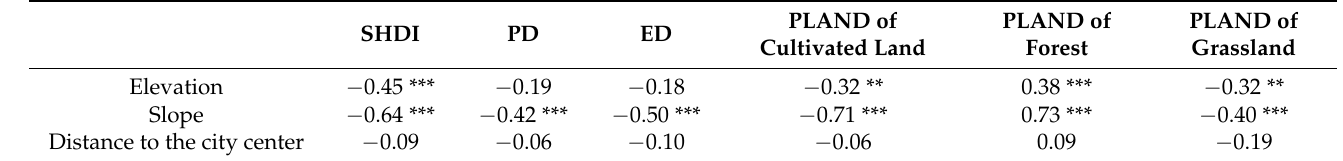
Table 5. Correlations between the landscape metrics (2020) and territorial variables.